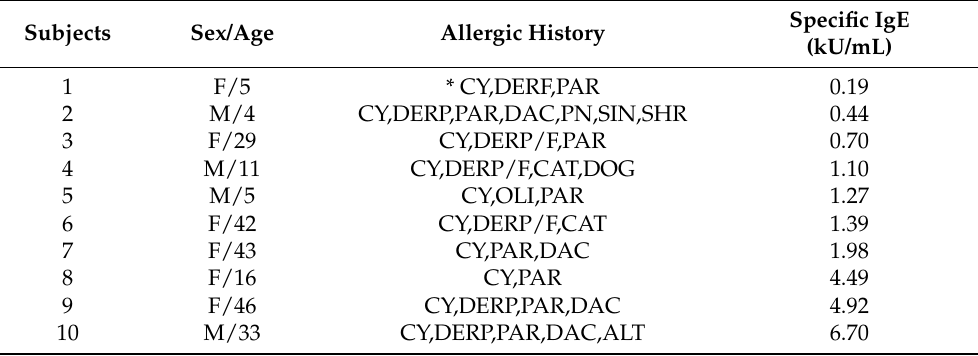
Table 1. List of sera from patients allergic to cypress pollen, used in SPOT and ELISA inhibition